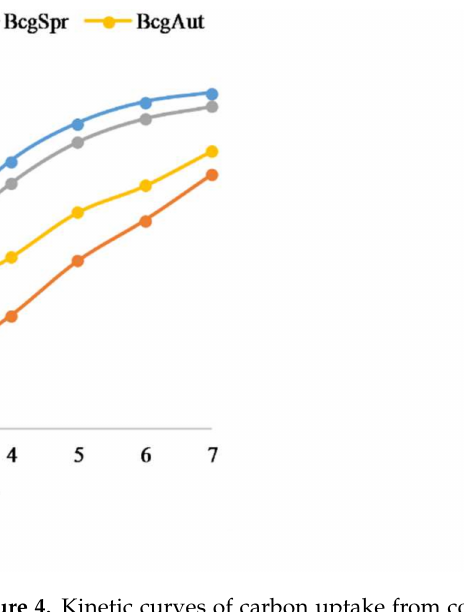
Figure 4. Kinetic curves of carbon uptake from communities in soil samples with different types of fertilization, expressed by AWCD ( A ), and bacterial activity, expressed by percentage uptake of substrates by category ( B ). Note: CH—carbohydrates; CA—carboxylic acids; AA—amino acids; PA—phenolic acids; PL—polyhydric alcohols;